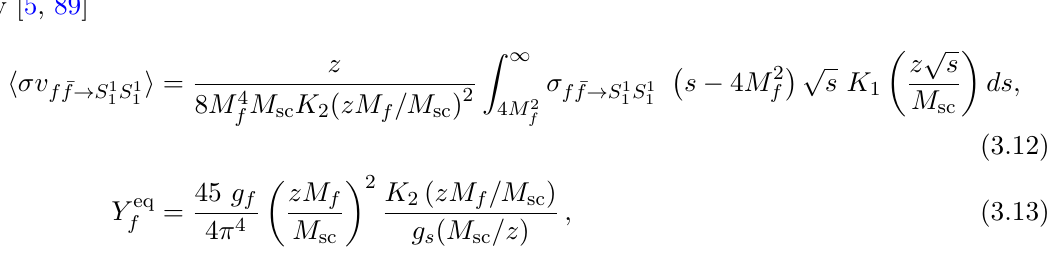
= 10 keV and di(cid:11)erent values of the WDM mass M S 1 1